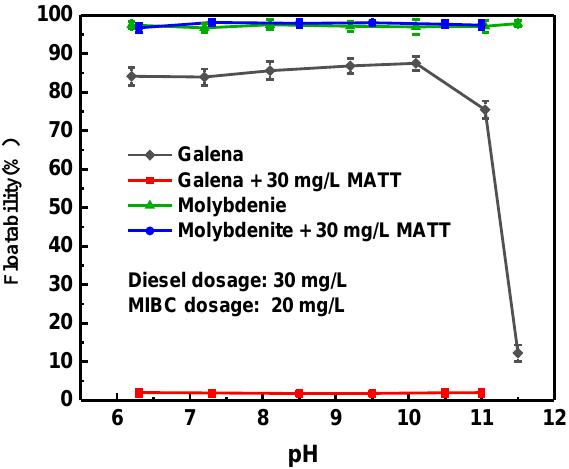
Figure 4. Floatability of galena and molybdenite as a function of the pulp pH.